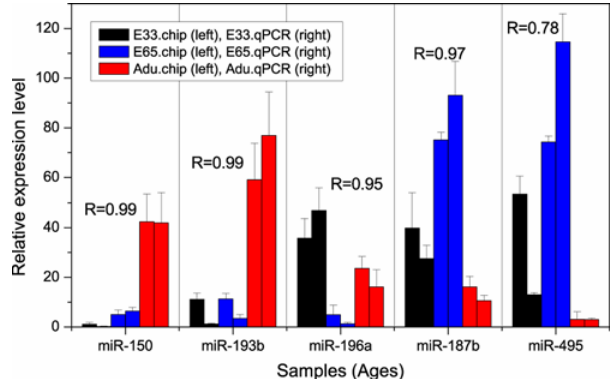
Figure 2. Validation of the microarray results using Real-time PCR method. Expression levels of five miRNAs (miR-150, miR-193b, miR-196a, miR-187b and miR-495) were detected by Real time PCR (right) and microarray (left). We have made a scaling to the raw data of Real time PCR to make it comparable to the microarray data. R represents the Pearson correlation